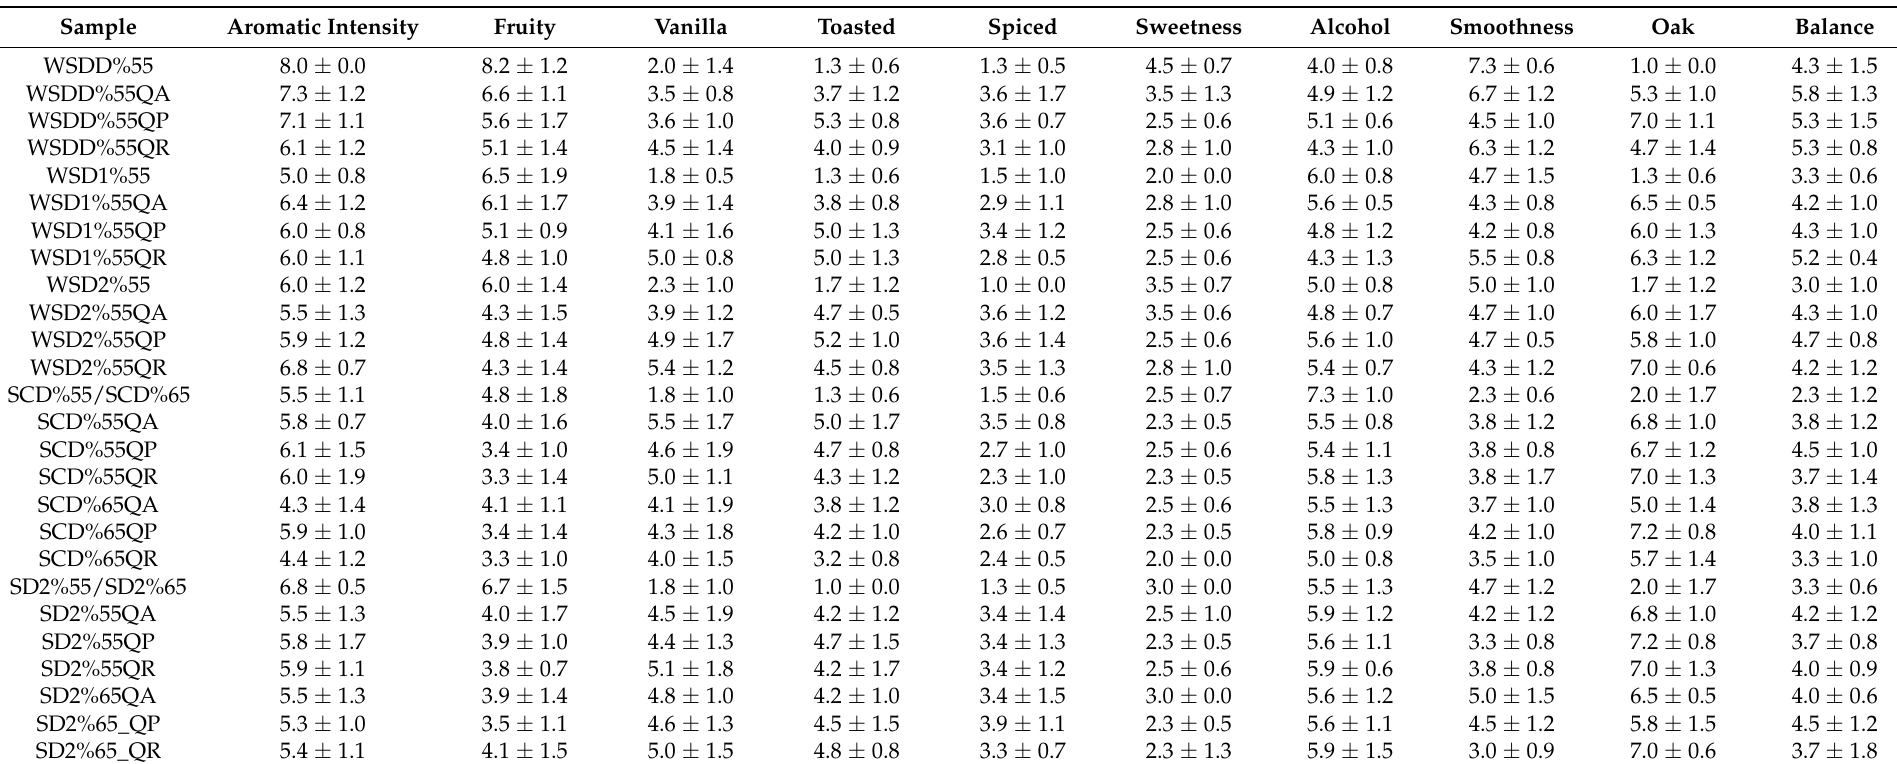
Table 8. Sensory characterization of the young and aged spirits included in this work. The scores are expressed as the mean ± standard deviation of the tasting panel.